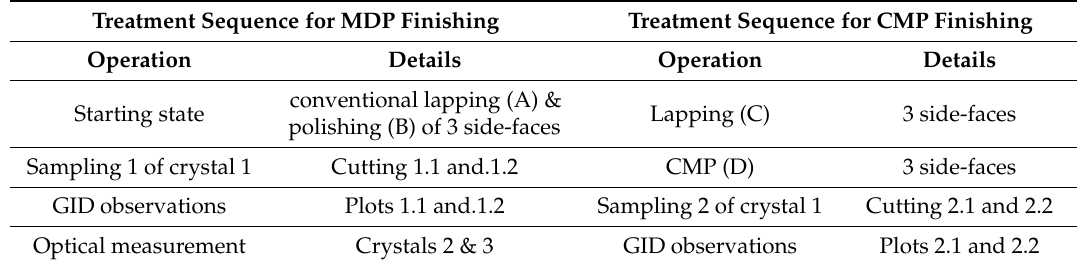
Table 2. Treatment